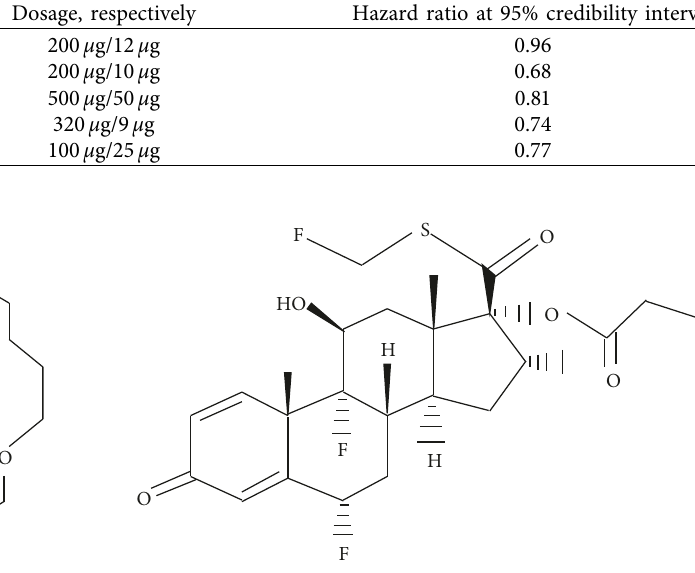
Figure 2: Chemical structure of fluticasone